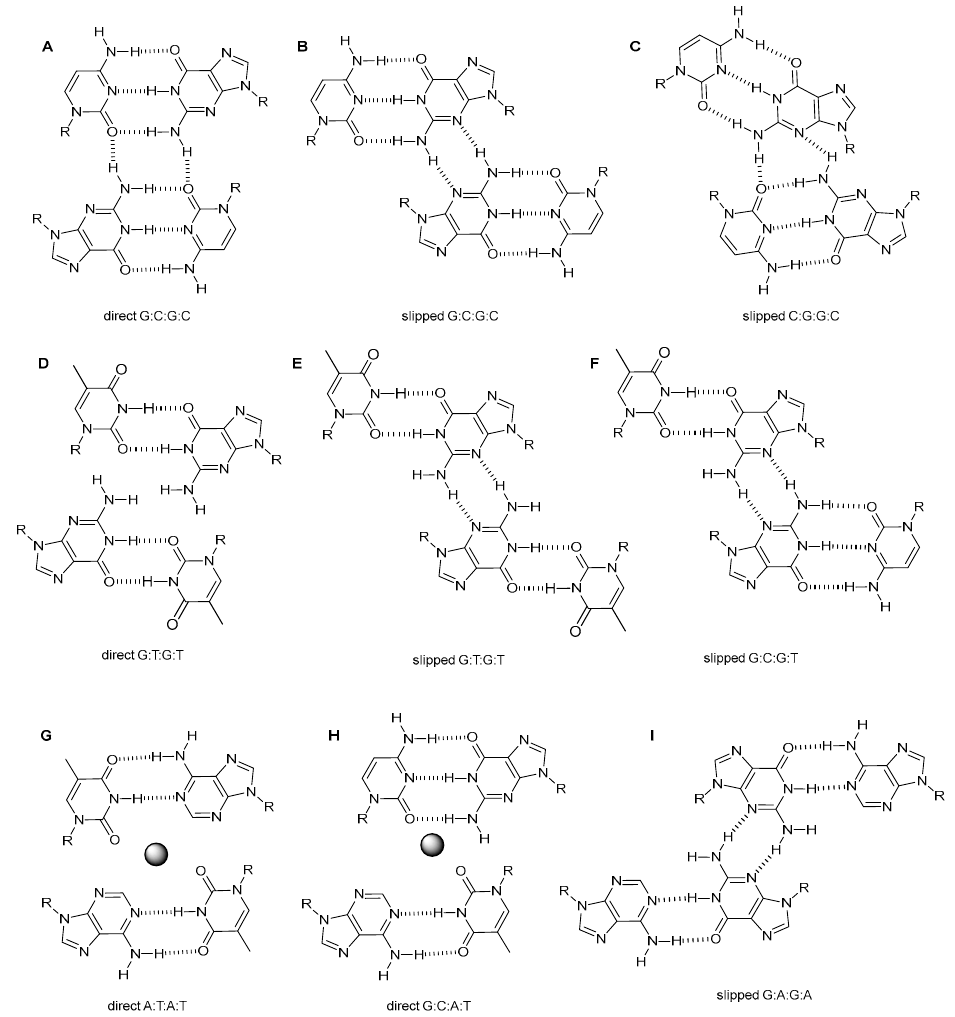
Figure 4. Schemes of the different minor groove tetrads discussed in the text. Direct ( A ) and slipped ( B ) minor groove G:C:G:C tetrads. ( C ) Minor groove C:G:G:C tetrad. Direct ( D ) and slipped ( E ) minor groove G:T:G:T tetrads. ( F ) Slipped minor groove G:C:G:T. Direct minor groove A:T:A:T ( G ) and G:C:A:T ( H ) tetrads stabilized by cation coordination (dark circle). ( I ) Slipped minor groove G:A:G:A tetrad.